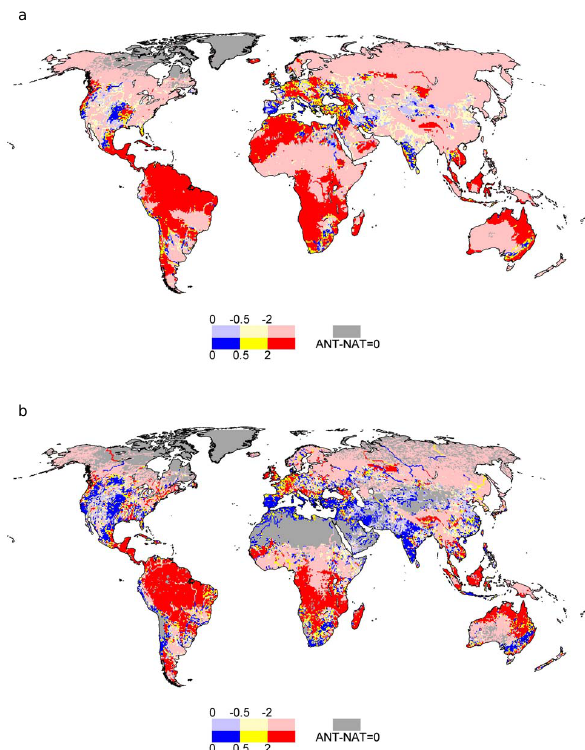
Fig. 5. Comparison of the impact of climate change to the im- pact of dams and water withdrawals, expressed as (CC-ANT – ANT)/(ANT – NAT), for long-term average annual discharge, I LTA (a) and monthly low flows Q 90 , I LF (b) . Red colors indicate that the climate change affects the two flow variables at least twice as much as dams and water withdrawals do, blue colors the opposite. Positive values indicate the changes due to climate change and with- drawal and dams are either both negative or both positive. Dams and withdrawals in the year 2002, climate change between 1961–1990 and 2041–2070 according to the emissions scenario A2 as imple- mented by the global climate model HadCM3.